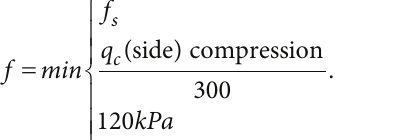
Table 6. A comparison of pile bearing capacity